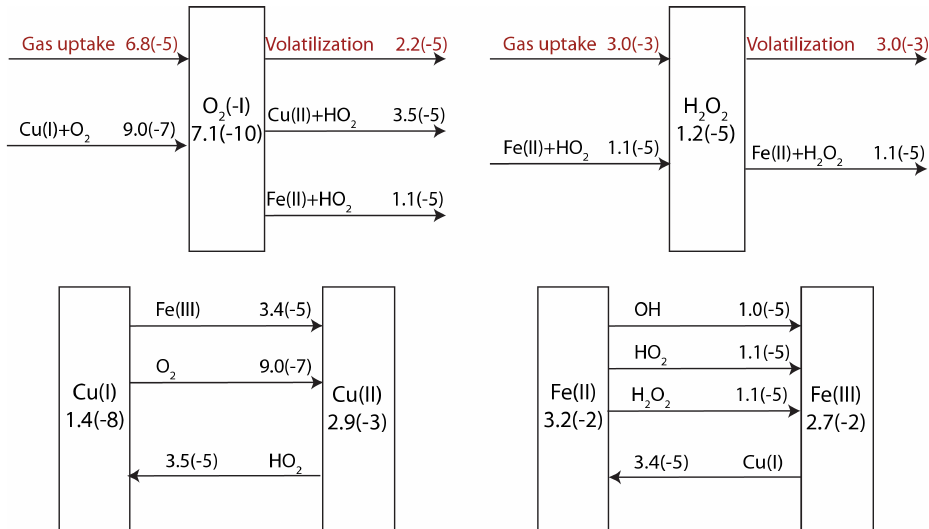
Fig. 2. Simulated aerosol budgets of O 2 ( − I) ≡ HO 2 (aq) + O − , H 2 O 2 , dissolved Cu, and dissolved Fe. The main reaction pathways are 2 indicated. The values shown are aqueous concentrations (M) and transformation rates (Ms − 1 ). Read 6.8( − 5) as 6.8 × 10 − 5 . The Cu(I) + HO 2 reaction (Reaction RA2) is not shown as it is negligibly small under these conditions. Model calculations assume an aqueous NH 4 HSO 4 aerosol with dry radius of 0.35µm at RH=85% and T =298K. This simulation is constrained with HO 2 (g)=10pptv, H 2 O 2 (g)=1ppb, O 3 (g)=30ppb. Aerosol pH is 0.15 with ionic strength 7.8molkg − 1 (the resulting activity coefficient A(Cu 2 + )=0.067). Dissolved Cu concentration is 2.9 × 10 − 3 M, adopted from Ross and Noone (1991). The dissolved Cu to Fe molar ratio is